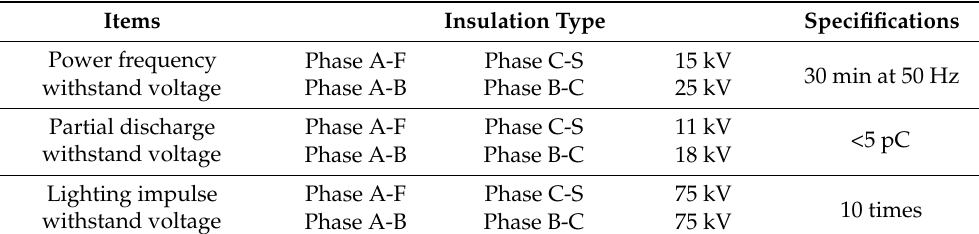
Table 3. Withstand voltage requirements of the 10 kV tri-axial HTS cable.